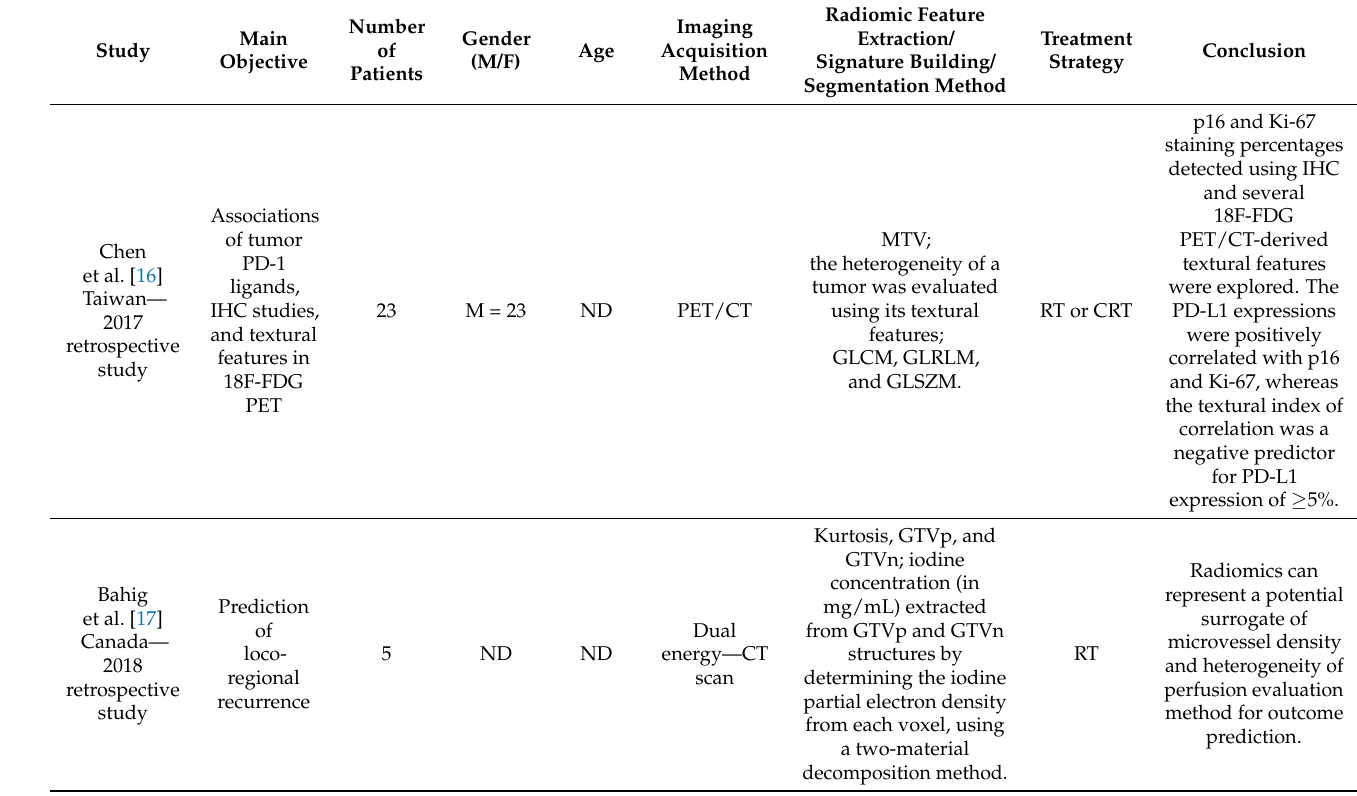
Table 1. Studies investigating the role of radiomics in hypopharyngeal cancer. Abbreviations: Not described = ND; metabolic tumor volume = MTV; gray-level co-occurrence matrix = GLCM; gray- level run-length matrix = GLRLM; gray-level size zone matrix = GLSZM; and LASSO = least absolute shrinkage and selection operator. Computed tomography = CT; magnetic resonance imaging = MRI, positron emission tomography = PET-CT; ultrasound = US; RT =radiotherapy; CRT = chemoradio- therapy; LR = linear regression; OS = overall survival; PFS = progression-free survival; and LFS = laryngectomy-free